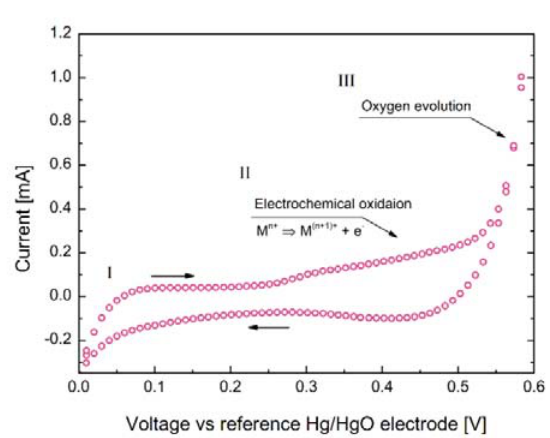
Figure 1. Cycling voltammogram recorded for SmBaCo 1.5 Mn 0.5 O 5+ δ oxide with a 5 mV s − 1 scanning rate. The M symbol represents the 3 d metals (i.e., Co and Mn) undergoing the oxidation process.